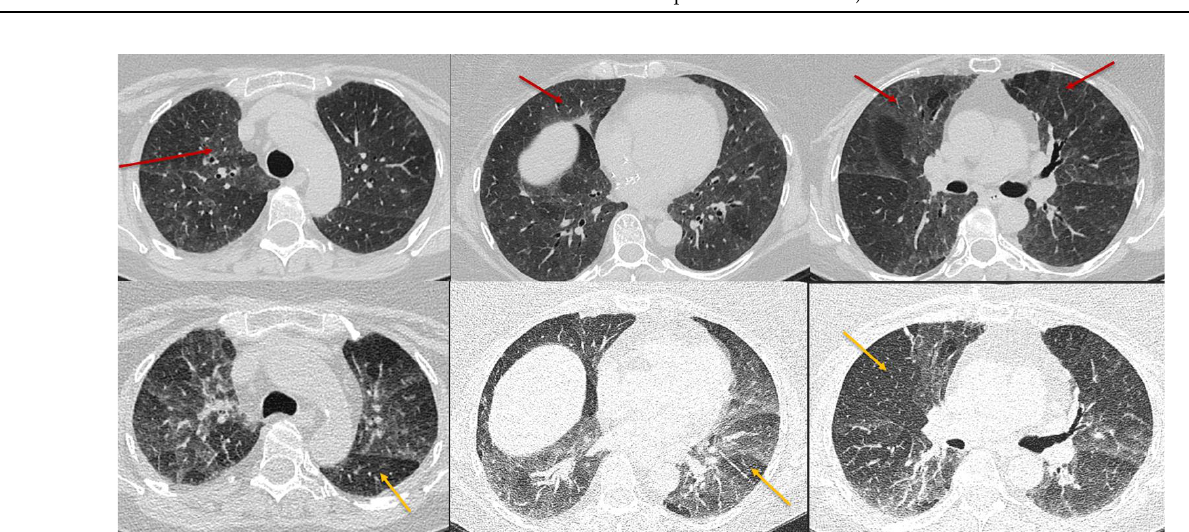
Figure 8. Typical non-fibrotic HP. Inspiratory phase CT (top row) shows ground glass opacities (red arrows) and expiratory phase CT (bottom row) shows air trapping (yellow arrows). Note the diffuse axial and craniocaudal distribution. Table 4. Patterns of fibrotic HP on a chest HRCT scan.